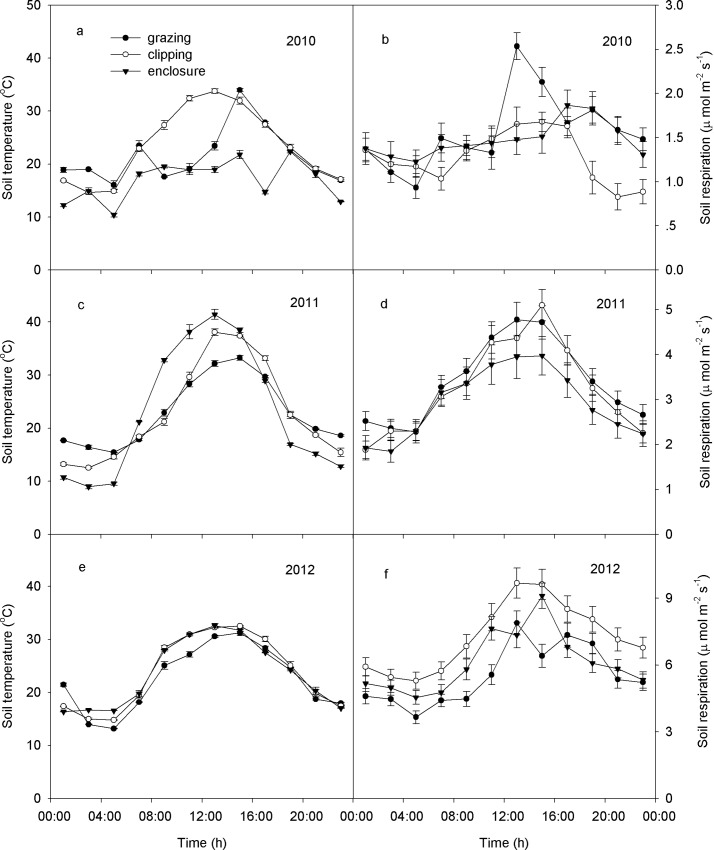
Diurnal variations in soil temperature (a, c, e) and soil respiration (b, d, f) under grazing, clipping, and enclosure on August 6–7, 2010, 2011 and 2012 (inset mean ± SE).